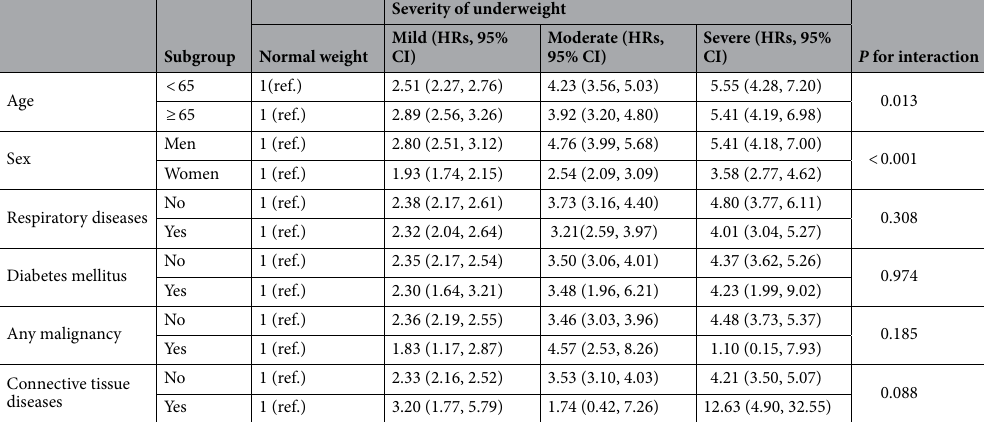
Table 4. Risk of non-tuberculosis mycobacterial pulmonary disease in subgroups according to age, sex, presence of diabetes mellitus, respiratory disease, any malignancy, and connective tissue diseases. Adjusted for age, sex, smoking, alcohol intake, regular exercise, respiratory diseases, solid cancer, hematologic malignancy, transplantation, AIDS, GERD, connective tissue diseases, diabetes mellitus. HR hazards ratios, 95% CI 95% confidence